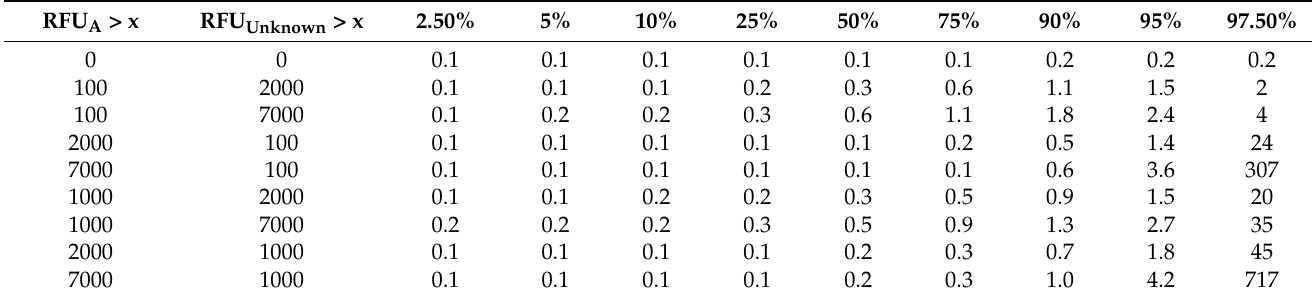
sensitivity analysis, showing 2.5–97.5 percentiles. The median (50 percentile) values are those that are reported. Results for the discrete model are shown in the top row; continuous models conditioned upon RFU A > x and RFU unknown > x are shown in remaining